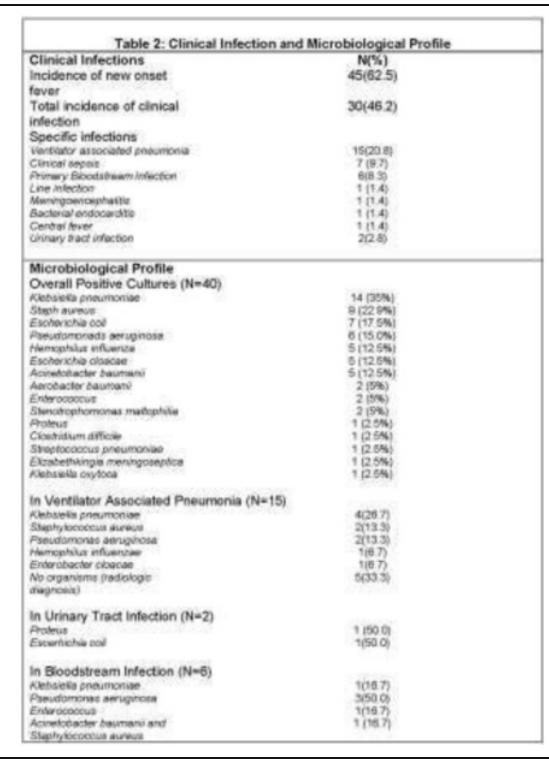
Table 47 (abstract A122). Clinical Infections and Bacteriological